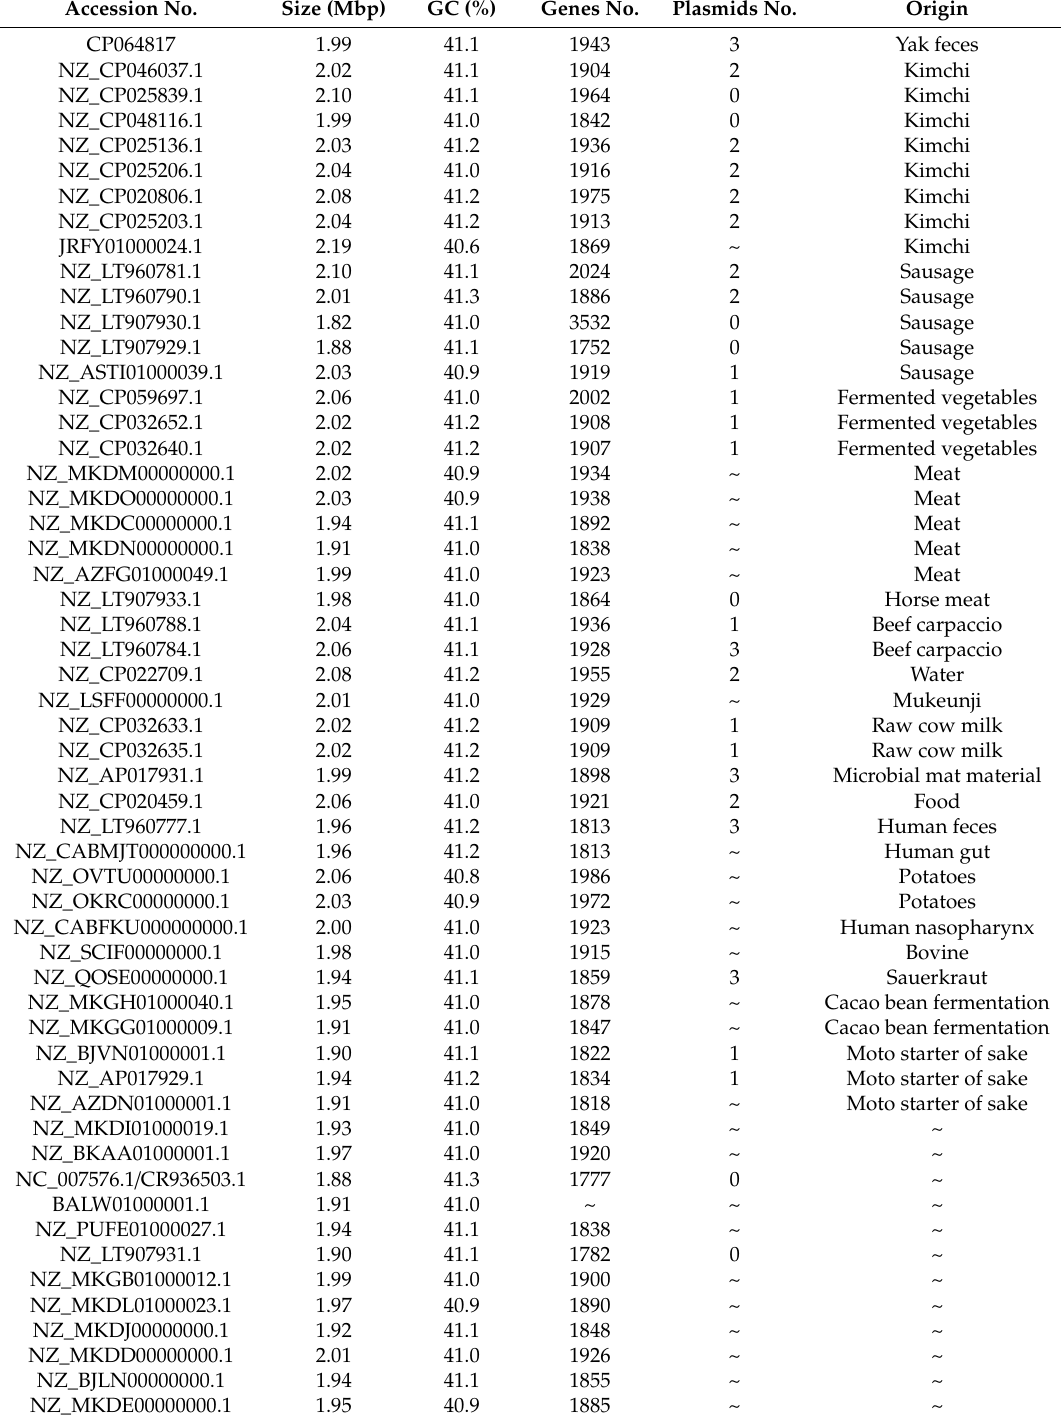
Table 4. Characteristics’ analysis of available L. sakei